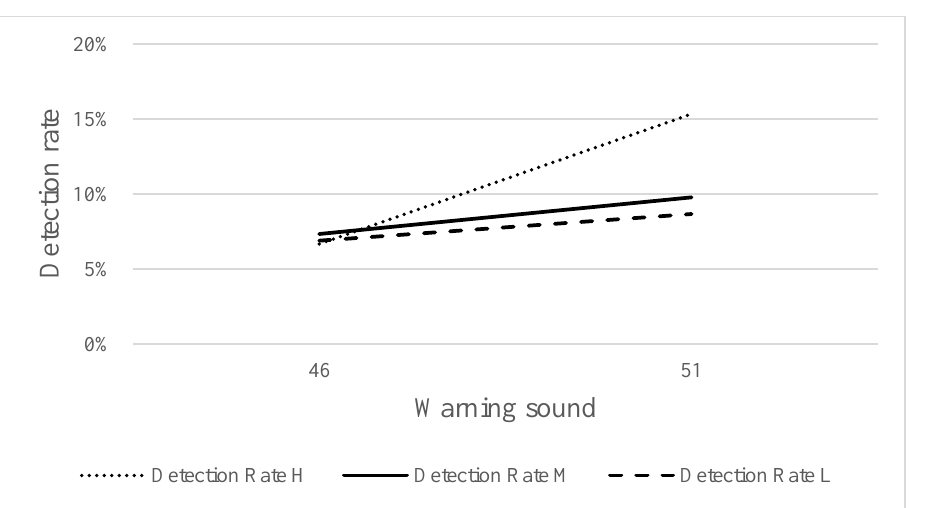
Figure 7. Detection rate with two SPLs of warning sounds under three frequencies of warning sounds (H, M, and L indicate high-, medium-, and low-frequency warning sounds).